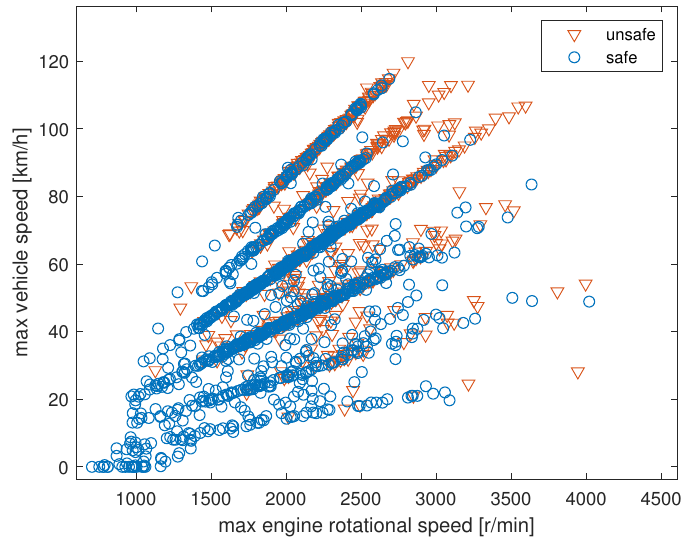
Figure 3. Scatter plot of the maximum value of the engine rotation speed versus the maximum value of the vehicle speed.